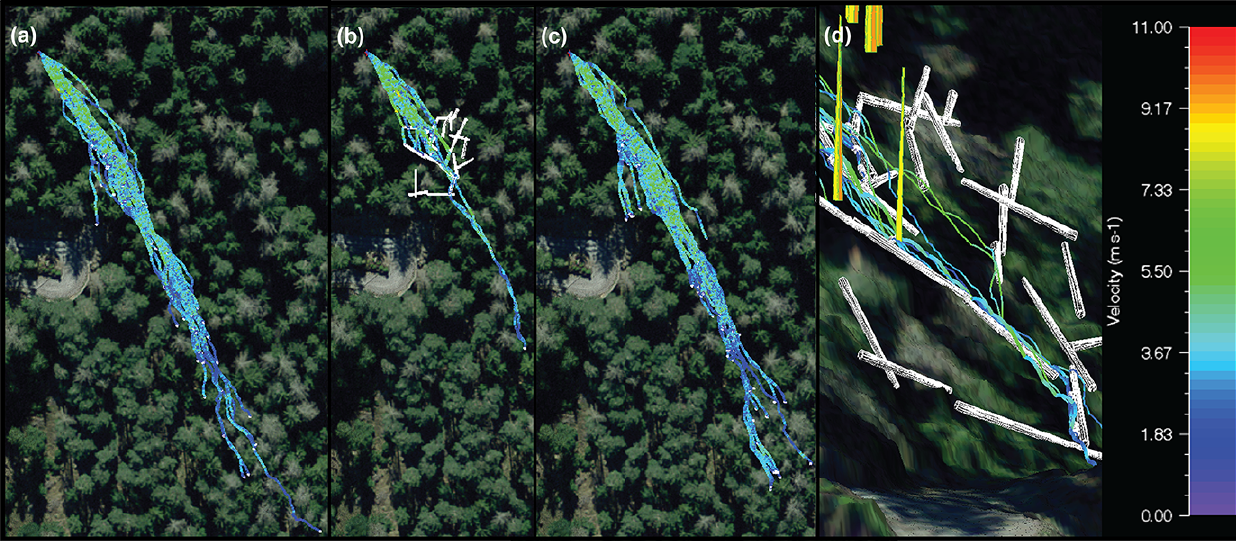
Figure 4. Velocity comparison of the 100 simulated rockfall trajectories in the (a) ORG, (b) DW and (c) CLR states of the forest. (d) Detailed three-dimensional view from above the forest road of the trajectories in (b) within the deadwood section: lying deadwood in white and standing trees in yellow. Source of orthophotos (a–d) : Federal Office of